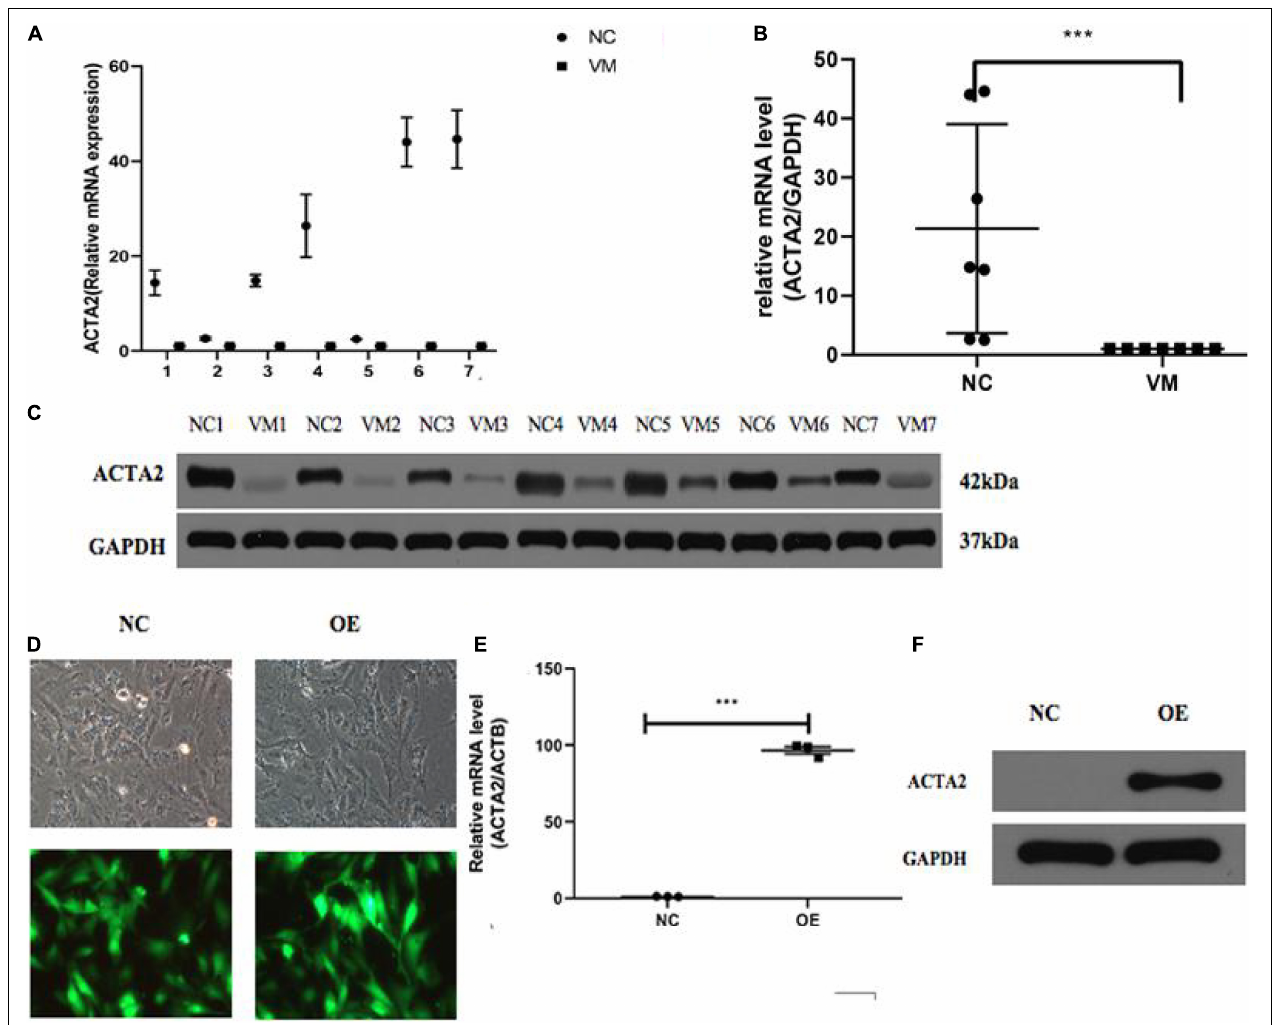
FIGURE 3 | Lower expression of ACTA2 in VM tissues. (A,B) The RNA expression level of ACTA2 in 7 pairs of normal and VM tissues. (C) Western blotting shows ACTA2 protein expression in 7 pairs of normal and VM tissues. (D) Light (up) and fluorescence (down) microscopy images confirming successful transduction of HMEC1 with LV-ACTA2(27000-1) virus and the control group. (E) ACTA2 expression levels were assessed by real-time RT-PCR, with GAPDH as an internal control. (F) ACTA2 expression levels were assessed by Western blotting. * P < 0.05, ** P < 0.01, *** P <